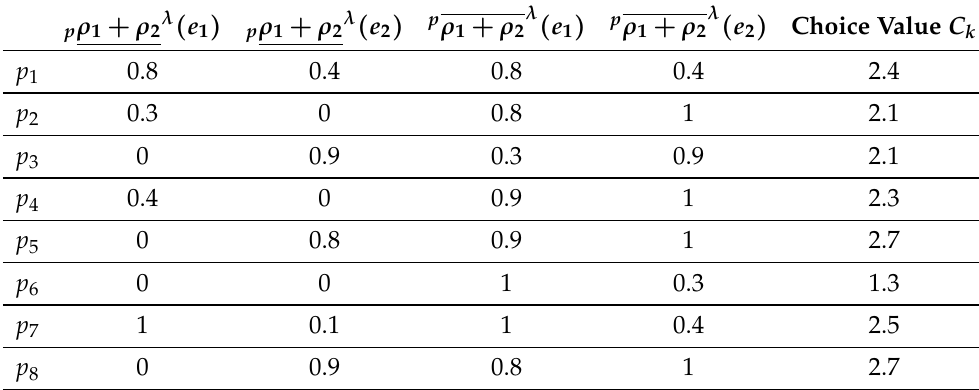
Table 1. The pessimistic result of the decision algorithm with respect to the